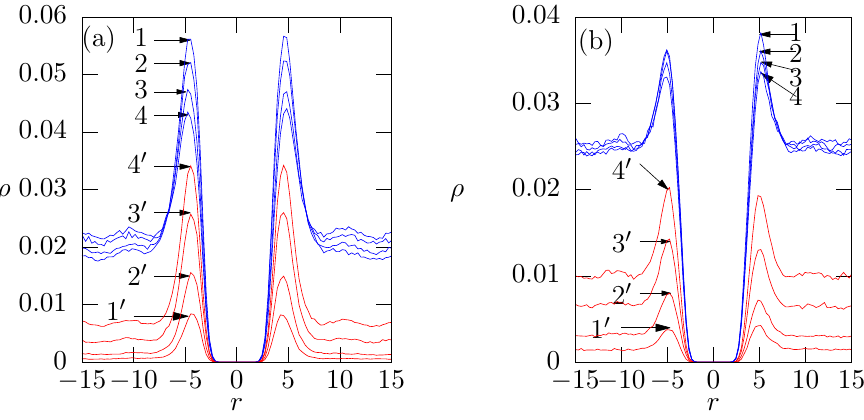
Figure 4. ( a ) Concentration profiles of monovalent and divalent ions added to the membrane; ( b ) Change in concentration profiles of ions after addition of the positively charged oligomer chains. In ( a ), curves (1), (2), (3) and (4) corresponds to concentration of monovalent cations in systems with increasing amount of Me 2 + from 25, 50, 100 to 150; Curves ( 1 (cid:48) ) , ( 2 (cid:48) ) , ( 3 (cid:48) ) and ( 4 (cid:48) ) corresponds to Me 2 + added to the membrane. In ( b ), curves (1), (2), (3), (4) corresponds to monovalent cations, curves ( 1 (cid:48) ) , ( 2 (cid:48) ) , ( 3 (cid:48) ) and ( 4 (cid:48) ) to Me 2 + with 32 added oligomer